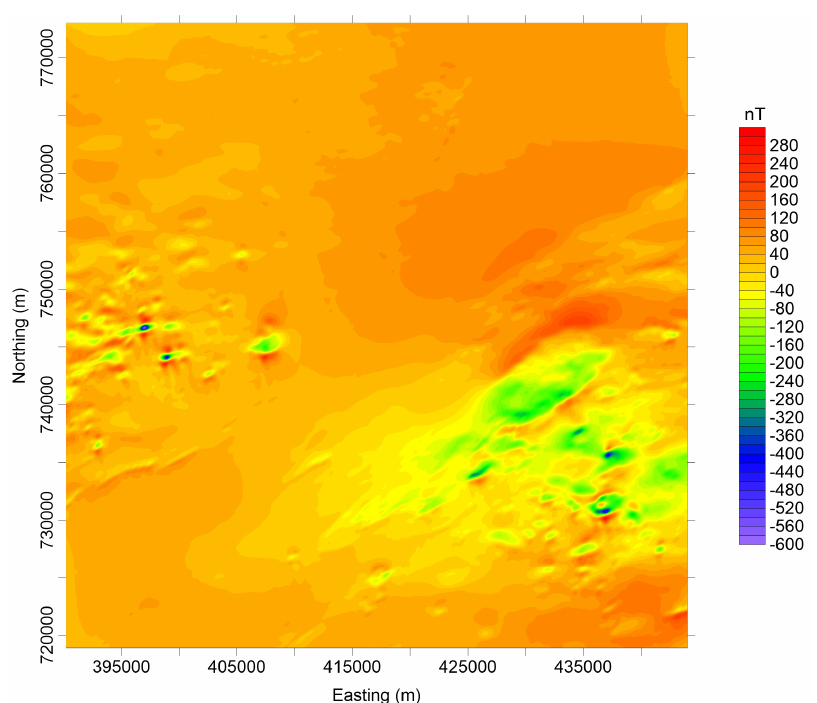
Figure 3. Total magnetic intensity data reduced to equator and upward continued to 100 m.